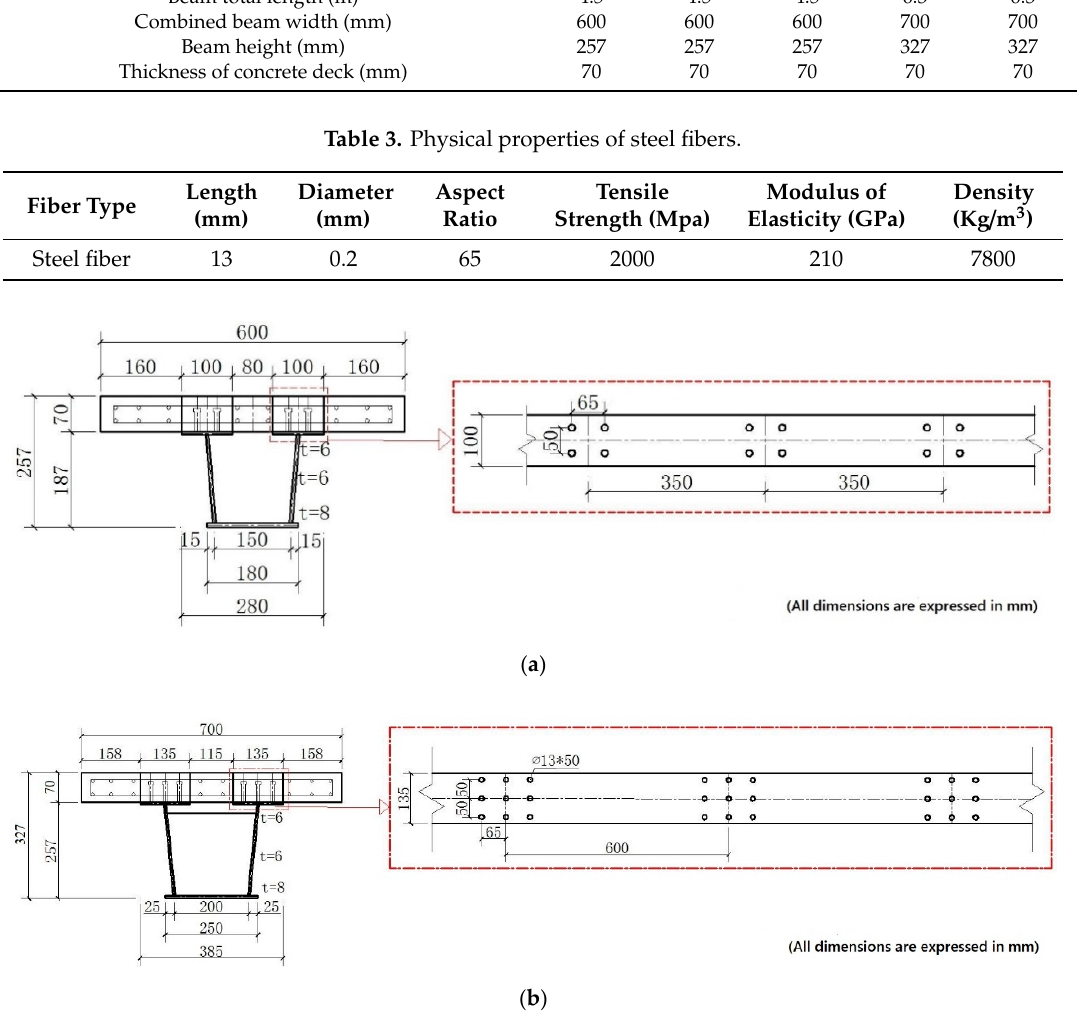
Figure 1. Details of stud arrangement cross-section of experimental accelerated construction steel-concrete steel fibrous high-performance composite box girder bridge. ( a )Typical arrangement of a simply supported beam (SPB1); ( b ) Typical arrangement of a continuous beam (ECB-2).